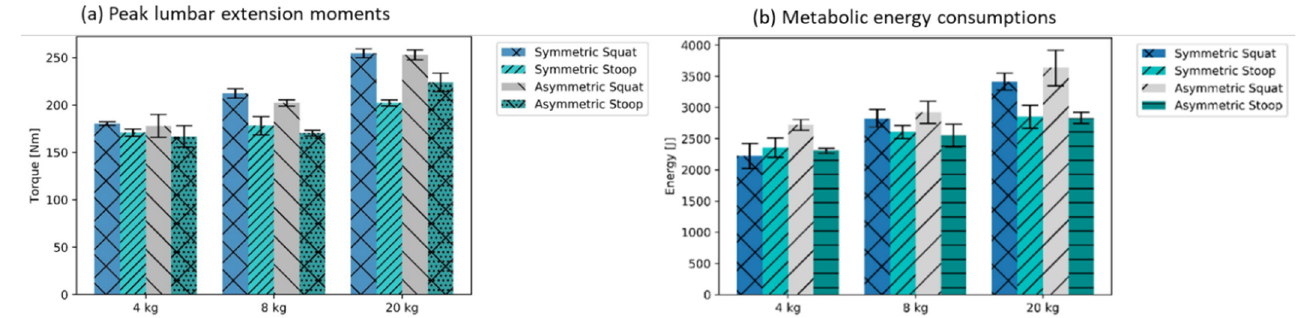
Figure 7. Mean peaks over five trials for lumbar extension moments and metabolic costs, both approximated based on the modeling assumptions in the AMS